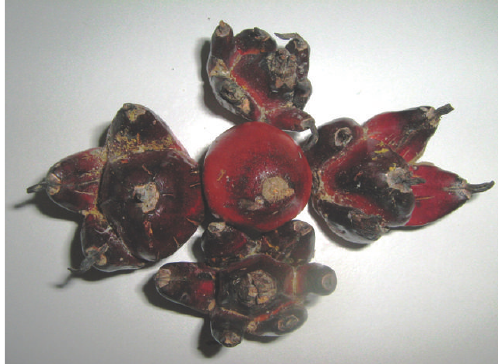
Figure 2: Different degree of mantling (number of “finger”). Source: from AAR.